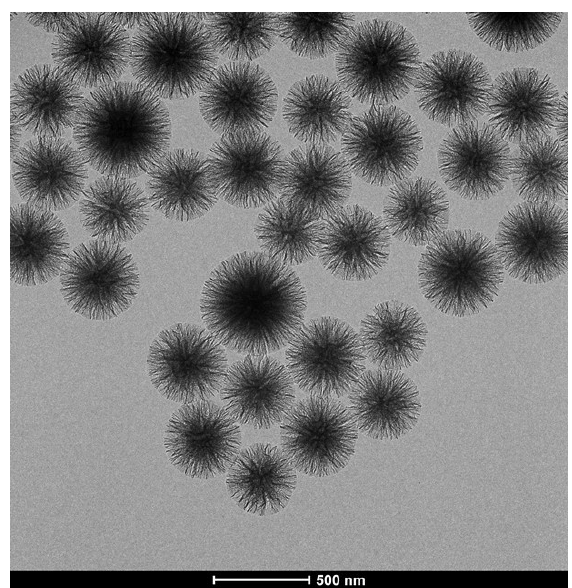
Figure 2. TEM micrographs of WSN-p at low magnification.